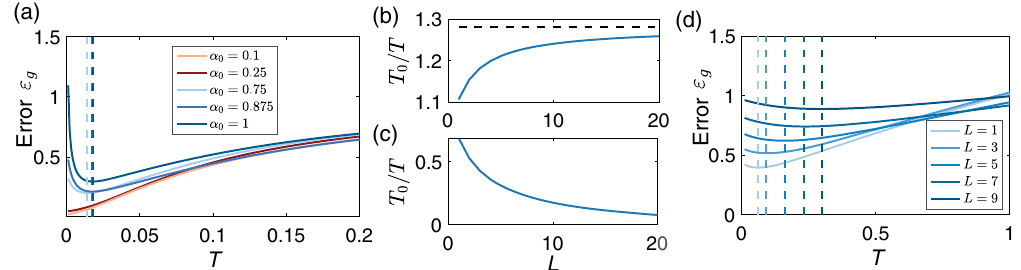
FIG. 7. Finite-temperature theory according to Eqs. (47) and (48) for a network trained on the template model with random labels (see parameters in Appendix E) with finite temperature. (a) Generalization error against the temperature for three different α 0 ’ s. Dashed lines: optimal temperature for each α 0 . For this specific type of input data, for small α 0 ( α 0 ¼ 0 . 1 , 0.25), the optimal temperature is at T ¼ 0 ; for α 0 close to 1 ( α 0 ¼ 0 . 75 , 0.875, 1), the minimum generalization error is achieved at T > 0 . (b) For σ 2 ð 1 − α Þ < 1 , u λ ¼ u − L 0 approaches 1 and 0 approaches the finite value exp v 0 (black dashed line). (c) In another regime where σ 2 ð 1 − α Þ > 1 , u λ → 0 as L → ∞ . (d) Generalization error vs T for five different L ’ s. Dashed 0 approaches a limit larger than 1 and lines: optimal temperature for each L . In the regime σ 2 ð 1 − α Þ > 1 , since λ goes to 0 and the temperature term TI becomes more negligible compared to the renormalized kernel u L 0 K 0 as L increases, larger T is required to compensate for the small λ to obtain an optimal generalization